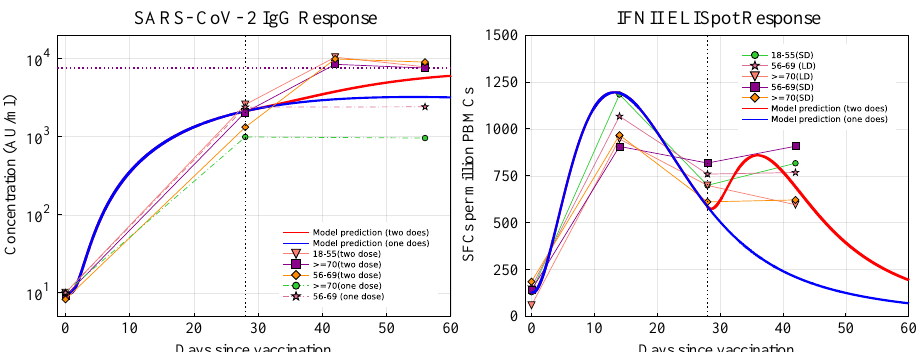
Figure 2. Antibody and IFN γ fit to the clinical trial data [1]. Blue and red solid lines: predicted results for participants who received one (blue) or two doses (red), with a boost dose at day 28 (shown by black vertical dashed lines). Left: The purple horizontal dashed line shows the maximum stimulated antibody level